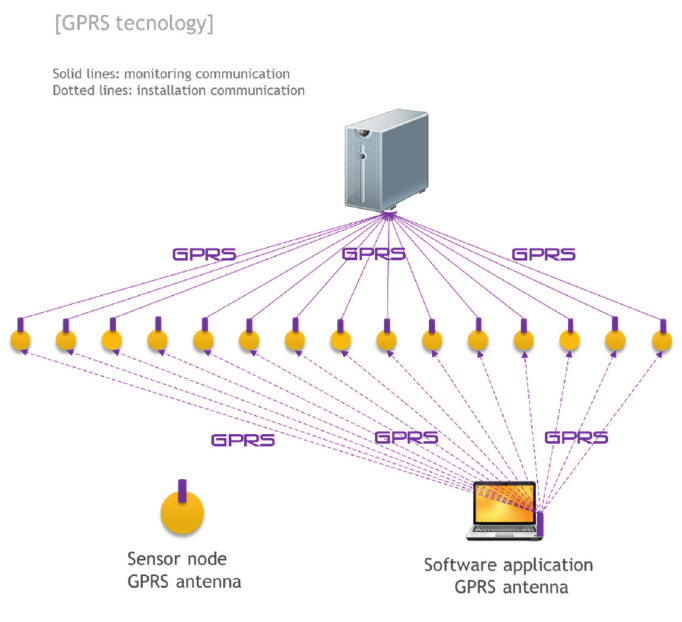
Figure 11. RFID: communication